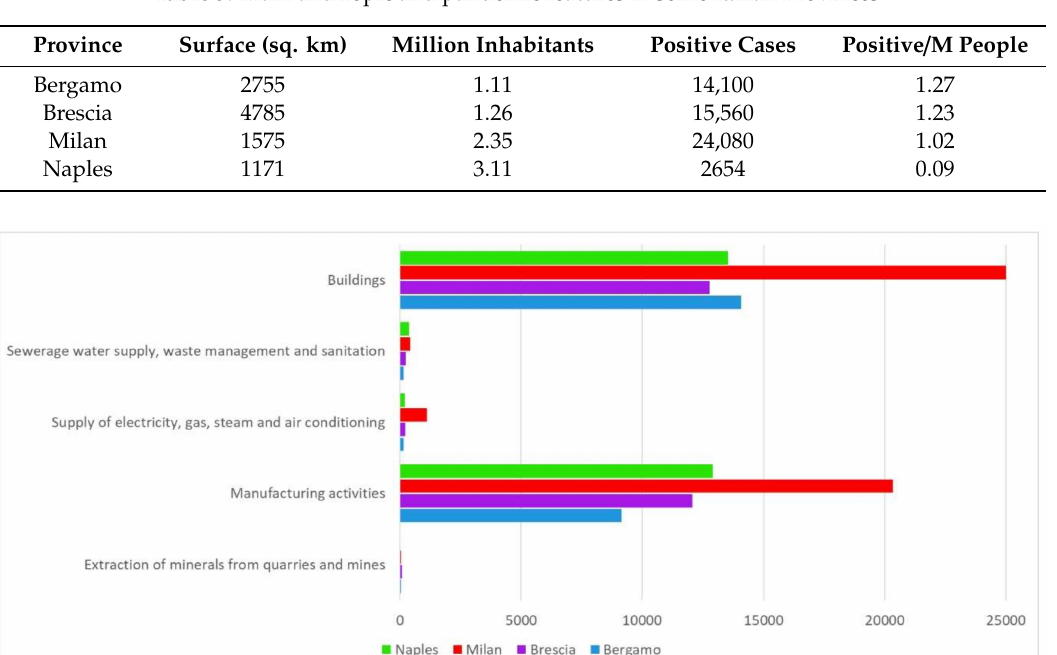
Table 3. Main anthropic and pandemic features in some Italian Provinces.